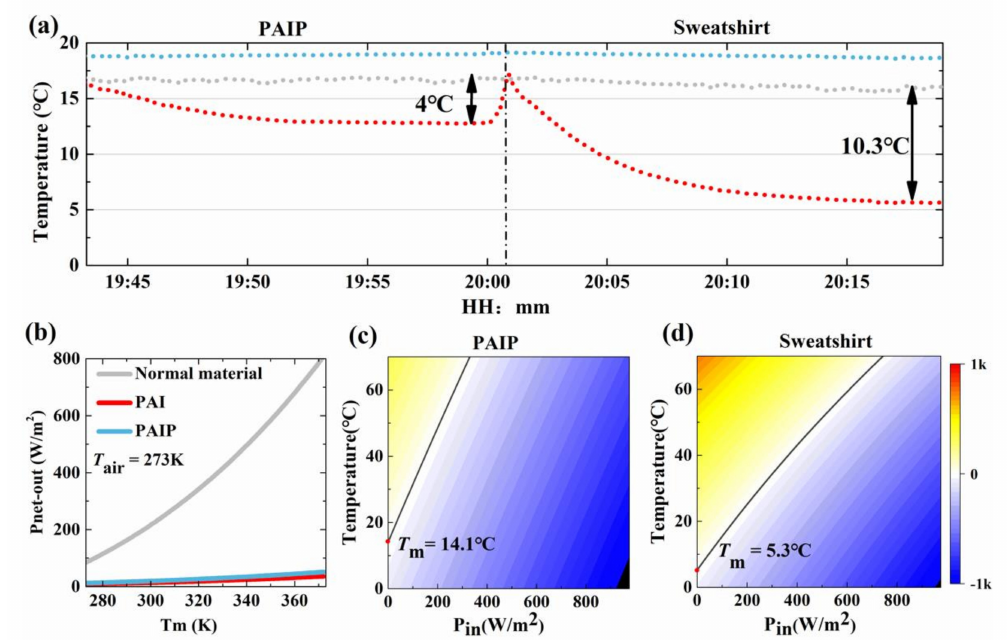
Figure 5. Indoor test results. ( a ) Experimental results of three points. ( b ) Intensity of P net-out of di ff erent materials under di ff erent temperature. ( c ) Temperature simulation result of indoor test of PAIP. ( d ) Temperature simulation result of indoor test of